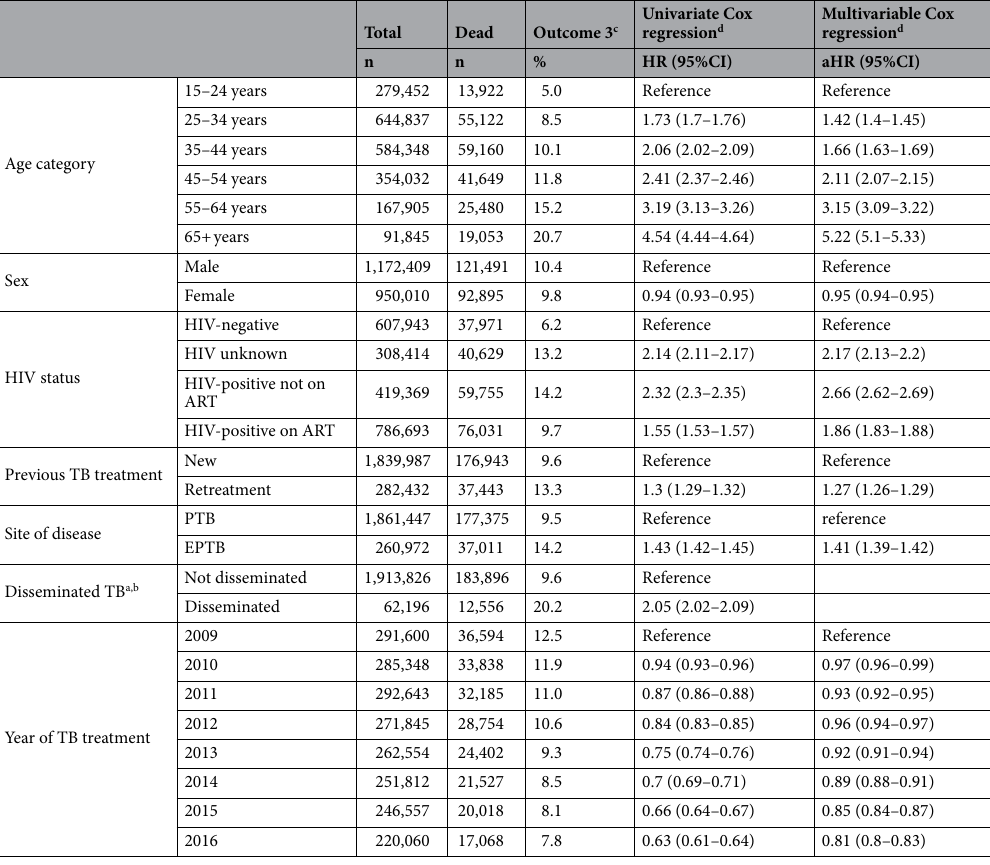
Table 3. Univariate and multivariable Cox regression model predicting hazard and adjusted hazard ratio of death among adults (≥ 15 years) with drug-susceptible TB and known vitality status, South Africa, 2009–2016 (n = 2,122,419). ART: antiretroviral therapy; EPTB: extrapulmonary TB; ICD10: International classification of disease 10; PTB: pulmonary TB; TB: tuberculosis. p-values not shown, all p-values in multi variable model significant < 0.0001. a Disseminated TB not added to final model due to collinearity with site of TB disease. b Disseminated TB included 146,397 with unknown classification due to missing ICD10 codes. c Outcome 3: calculated as percentage of deaths among those with known outcomes where person time on treatment was documented. d Cox regression models restricted to individuals with known final vitality status. Unknown outcomes (lost to follow up, moved or not evaluated) n = 409,114